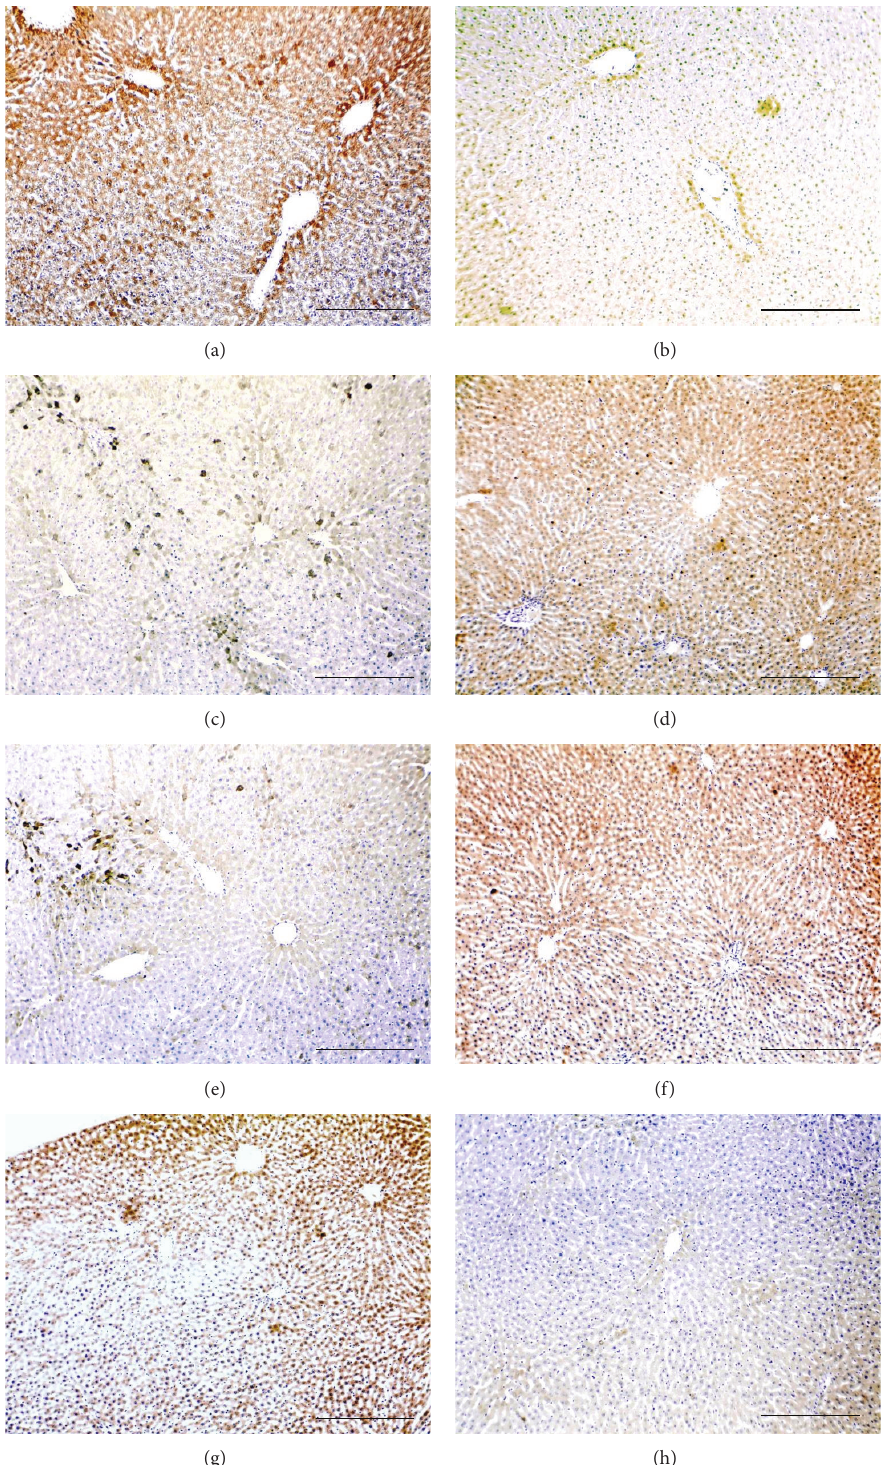
Figure 3: Immunohistochemistry localisation of Smad4 (left column) and Smad7 (right column) in control (a and b), Peg-only (c and d), Peg & RBV (e and f), and RBV-only (g and h) groups ( × 100 magnification, scale bar = 15 𝜇